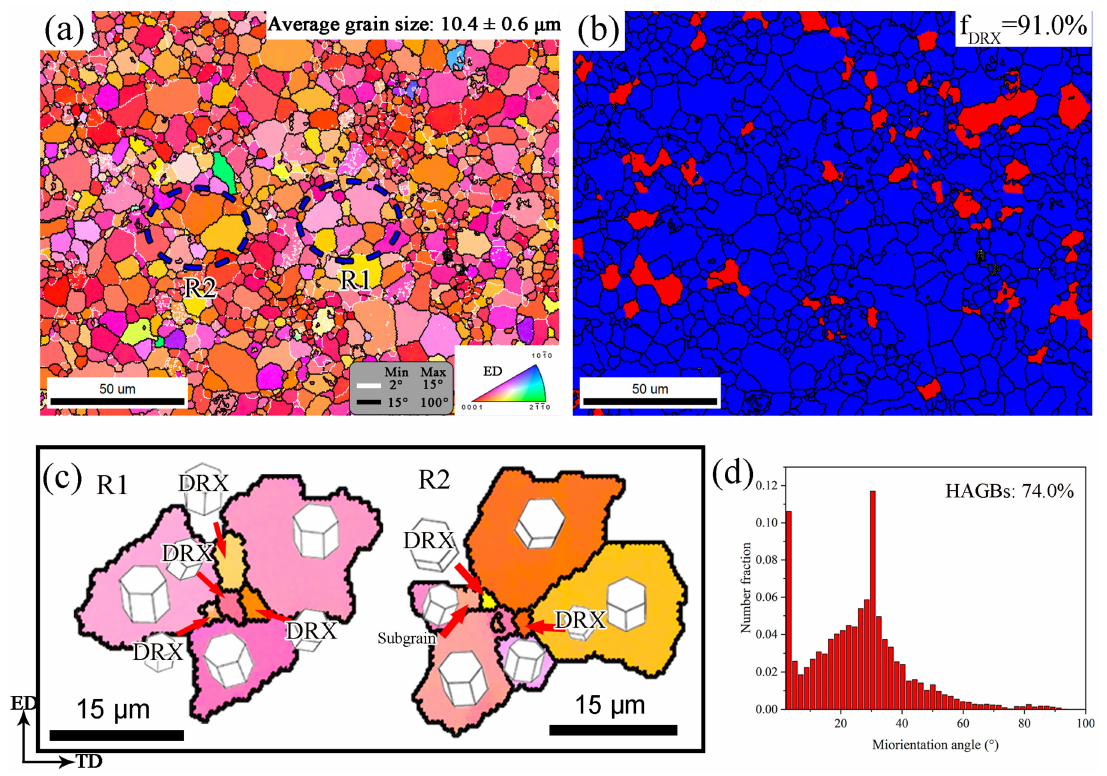
Figure 7. Microstructure of the sample after 3 passes of CEE-AEC: ( a ) inverse pole figure map; ( b ) grain orientation spread map; ( c ) the selected regions R1 and R2 in Figure 7a; and ( d ) misorientation angle distribution.